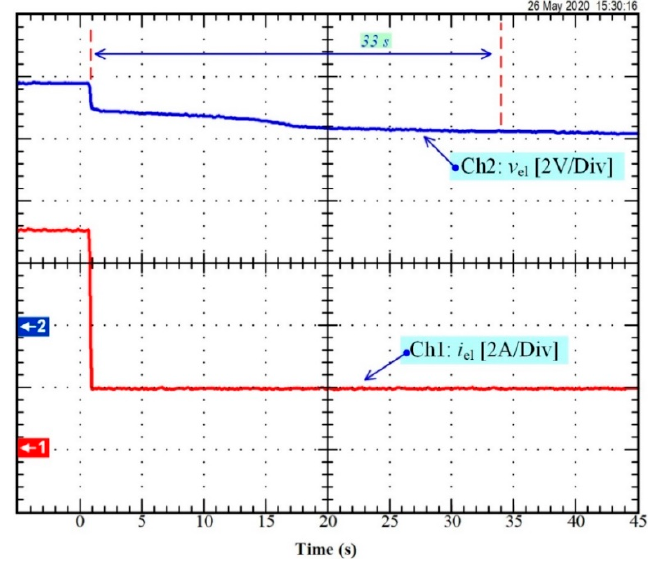
Figure 3. Response of the PEM electrolyzer as a result of a fall